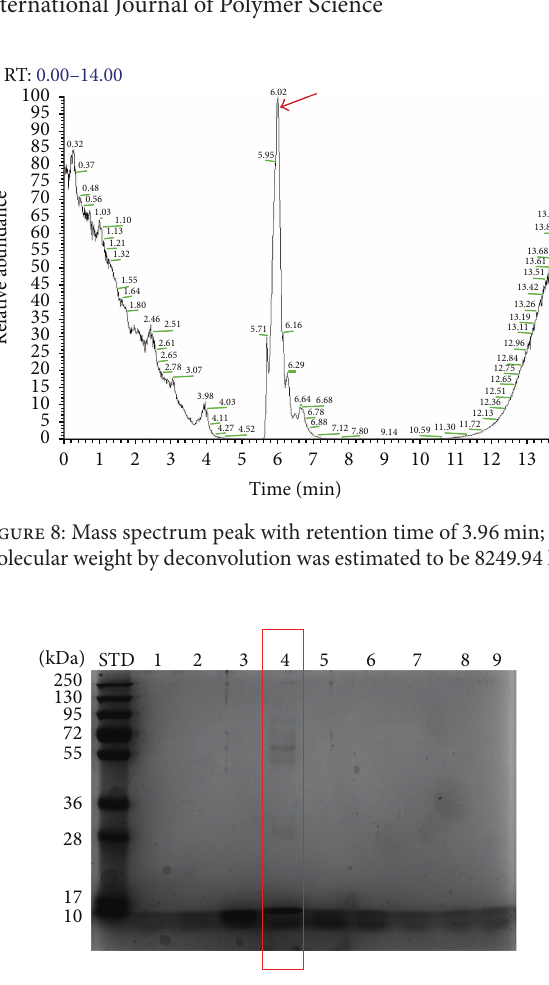
Figure 9: 12.5 SDS-PAGE run on samples and displaying peptides and proteins in lanes; STD is the molecular weight standard.